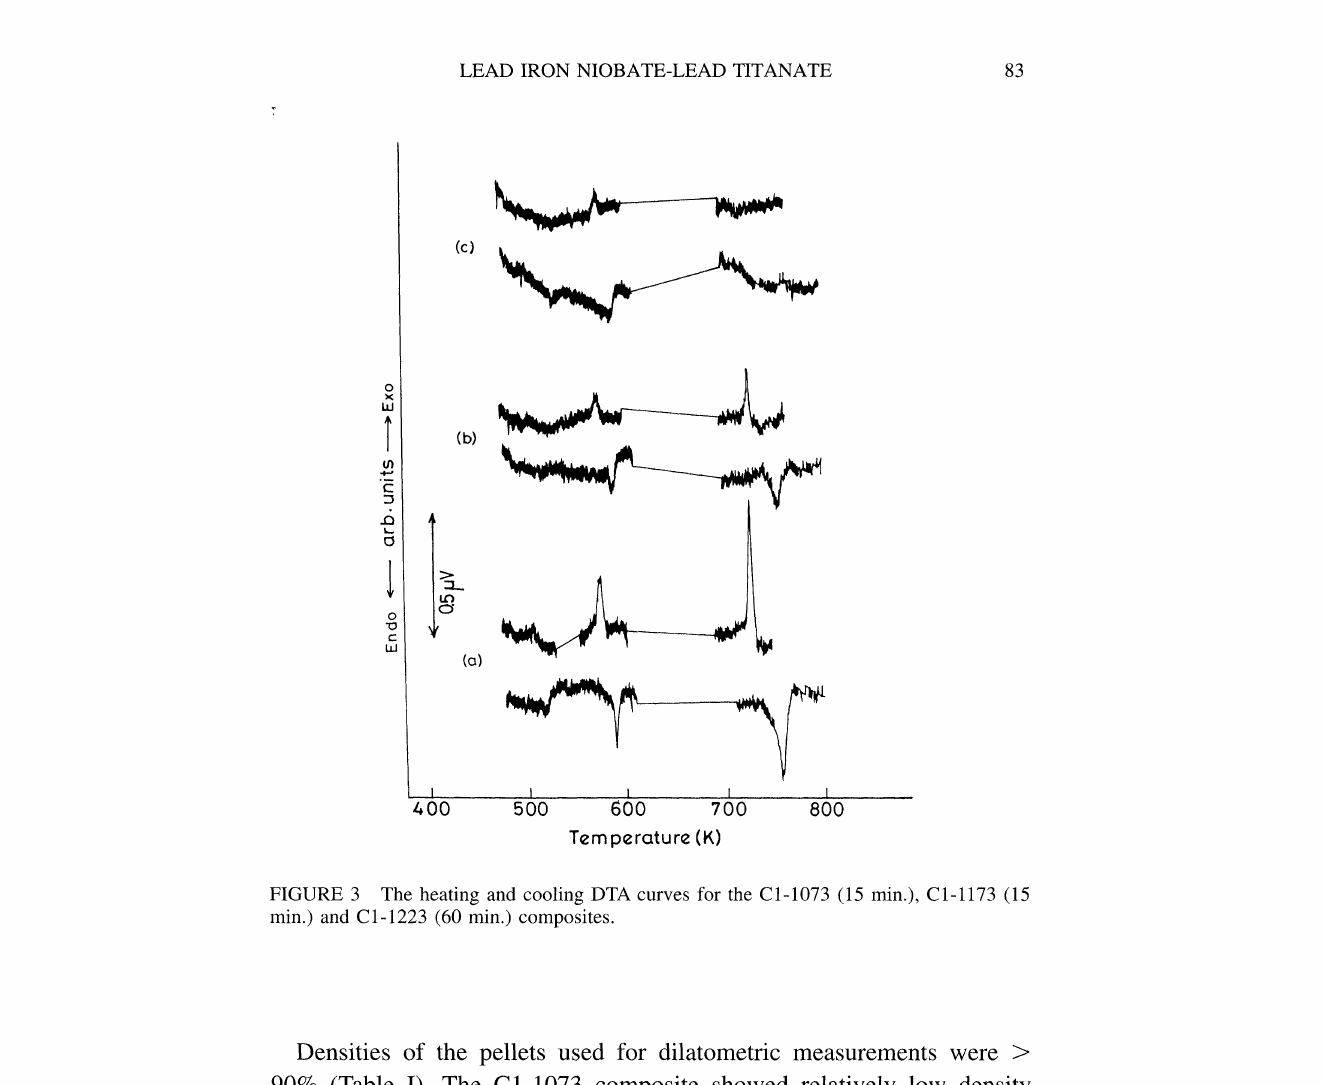
Densities of the pellets used for dilatometric measurements were > 90% (Table I). The C1-1073 composite showed relatively low density values (91%) as the compact could not have sintered sufficiently. Density values attained a maximum of 93.57 for C1-1223, and instead of a further increase at higher heat treatment temperatures, density reduced to 91% for C1-1323. This reduction was due to the formation of the solid solution. These results show that C1-1223 sintered for 15 min. or 60 min. does not show DTA signature of any phase transition and the maximum density can be achieved at this sintering